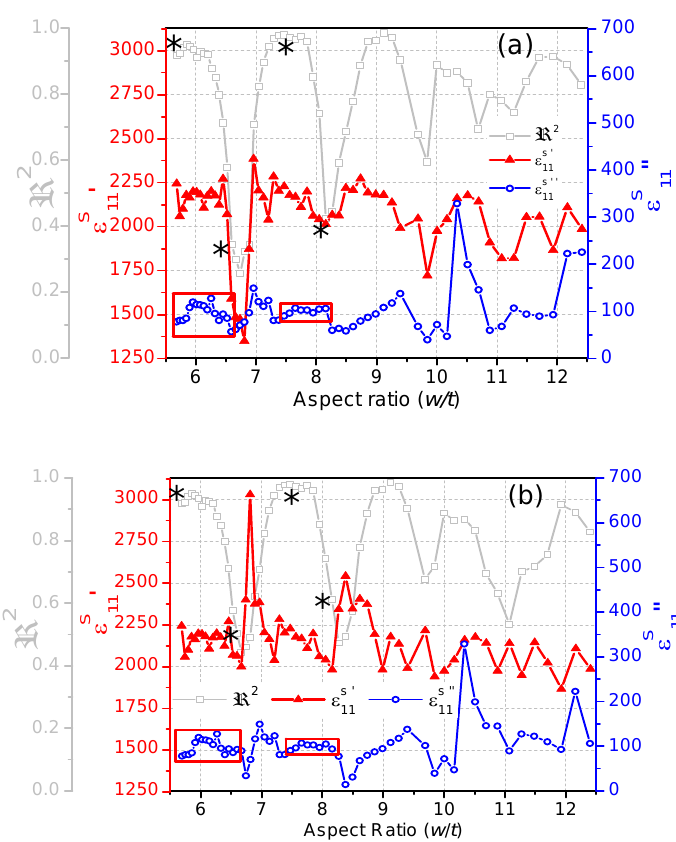
Figure 9. Evolution of the complex dielectric permittivity ε 11S as a function of the aspect ratio of the BCZT plate; the real and the imaginary parts ( ε 11S ´ and ε 11S ´´) are both plotted: ( a ) as ‐ calculated by the automatic iterative method; ( b ) as ‐ recalculated by the modified automatic iterative method. The evolution of R 2 is shown as a reference.